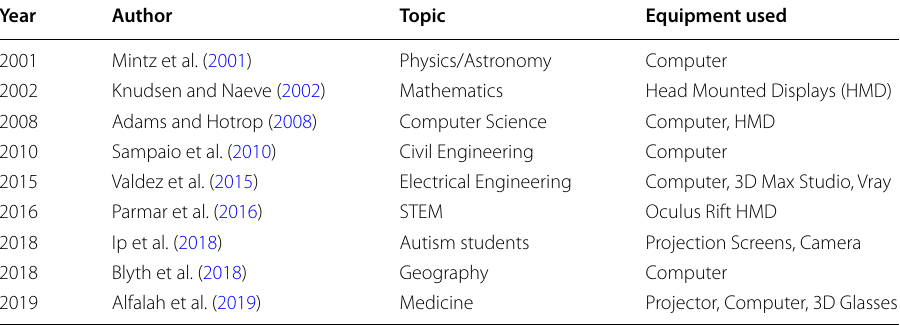
Table 4 Examples of educational VR applications used over the